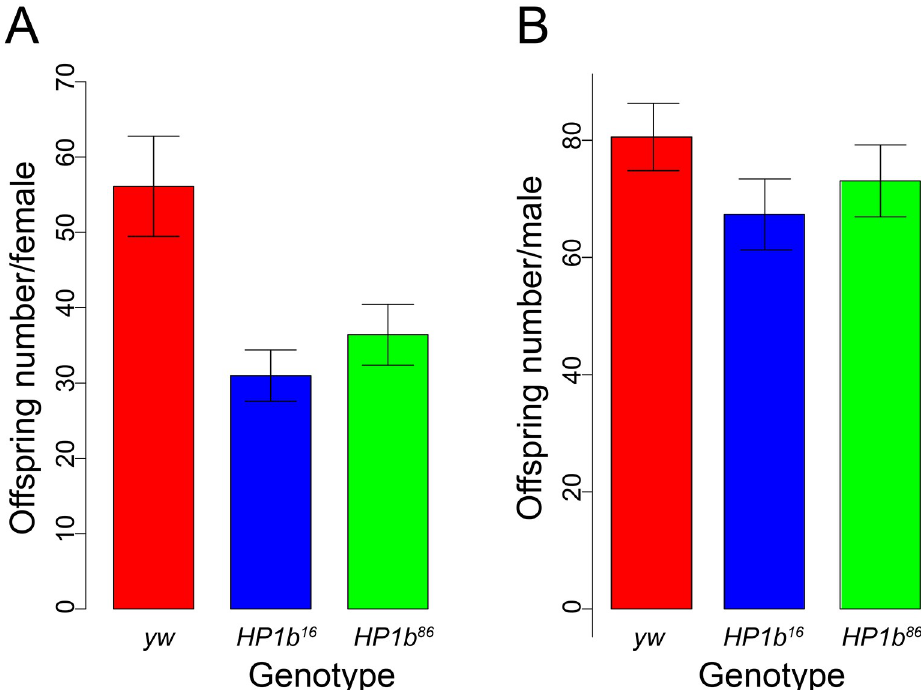
offspring in both HP1b 16 and HP1b 86 females is significantly reduced compared to yw females (t test, p < 0.05). B . The average offspring number for individual males of yw (red; n = 80), HP1b 16 (blue; n = 73), and HP1b 86 (green; n = 76) is shown (Y-axis). Error bars: SEM. The average offspring number of HP1b 16 and HP1b 86 males does not differ from that of yw males (t test, not